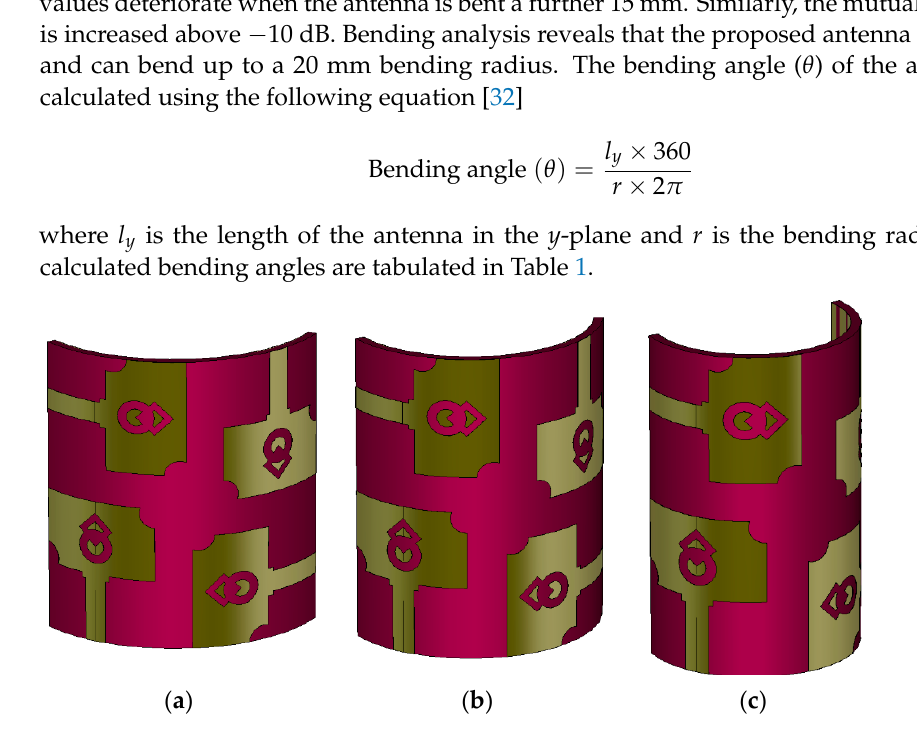
Figure 16. CCL plots of the MIMO antenna.